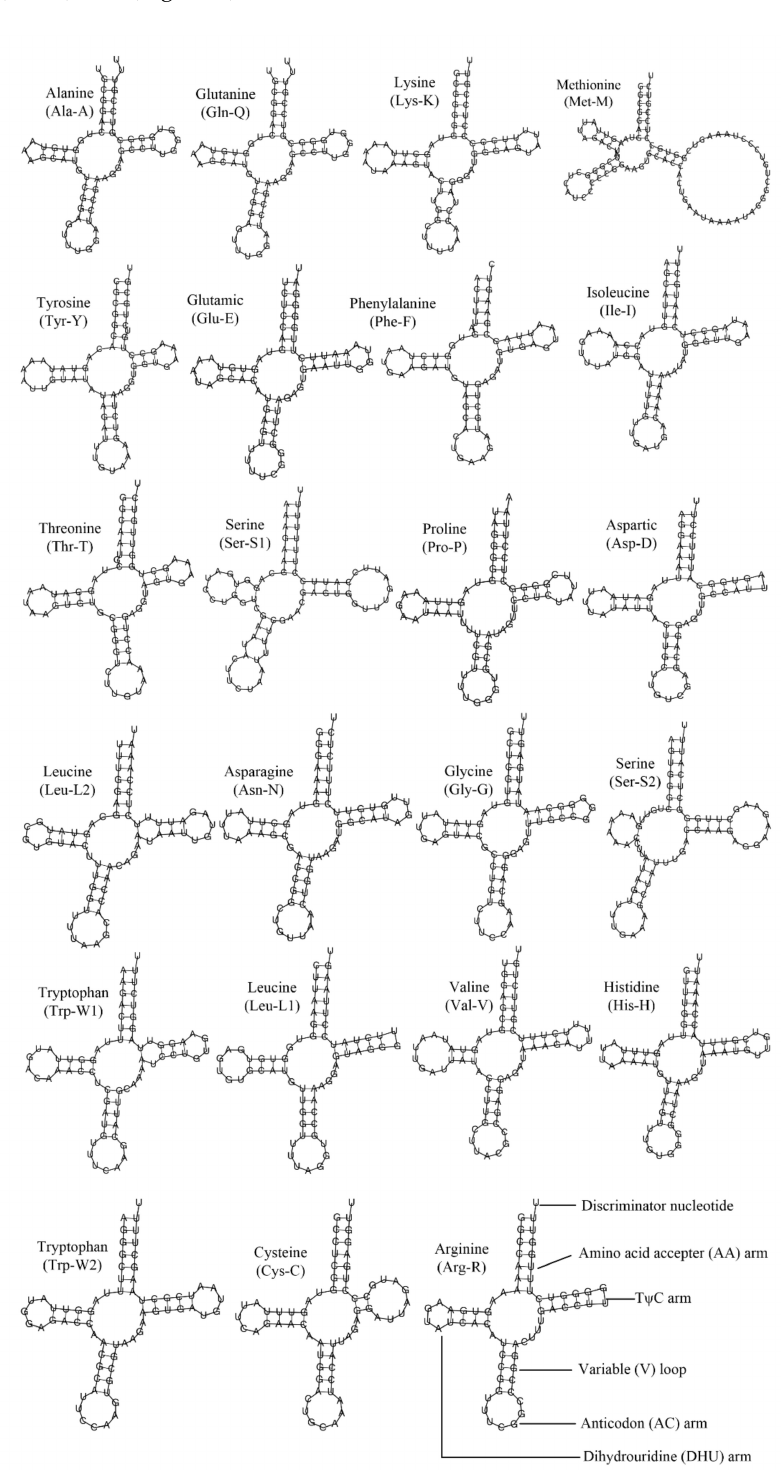
Figure 3. Inferred secondary structures of 23 transfer RNAs from Hyotissa hyotis